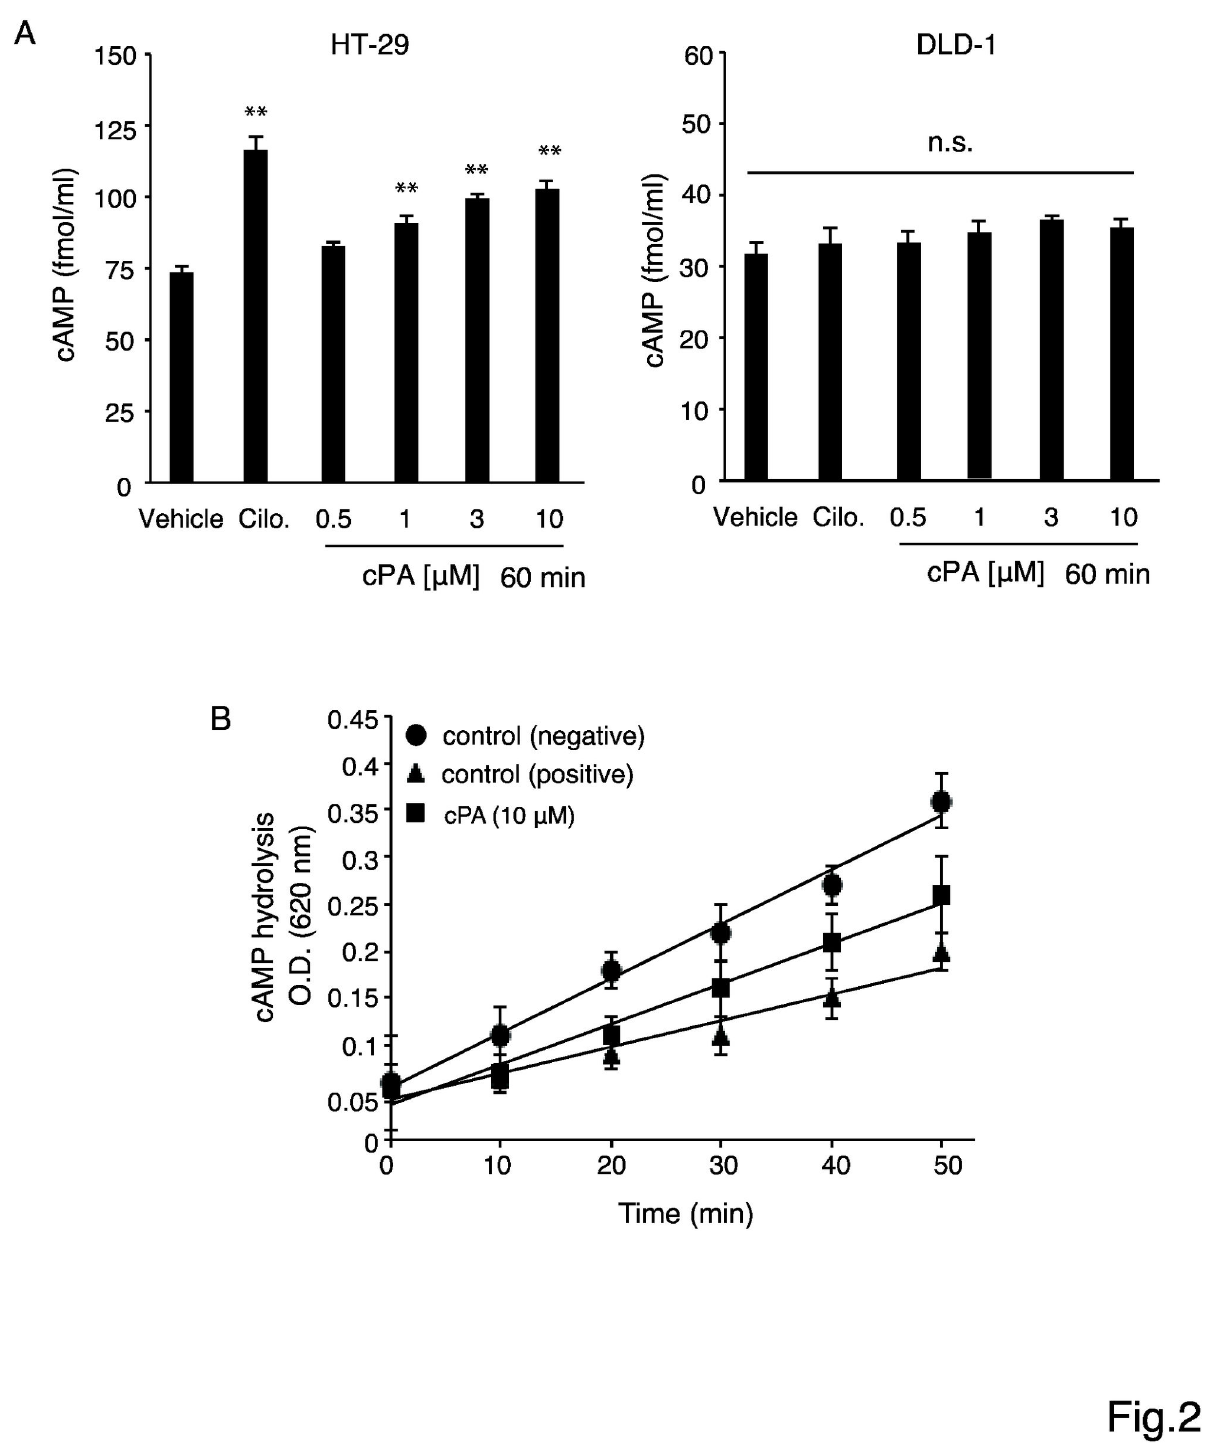
Figure 2. (A) Intracellular cAMP levels in HT-29 and DLD-1 cells treated with 0.5, 1, 3, or 10 μM cPA for 60 min. Intracellular cAMP levels in culture lysates were measured using the cAMP Biotrak Enzyme immunoassay system. Cilostazol (5 μM; Cilo) was used as a positive control. Data are expressed as means ± SEM (n = 4), **p < 0.01. (B) Time course of cPA-dependent inhibition of cAMP hydrolysis by PDE3B. PDE3B was incubated with cAMP and 5′-nucleotidase with or without the cPA (10 μM) for 10–50 min; the PDE inhibitor IBMX (50 μM) was used as a positive control. doi: 10.1371/journal.pone.0081139.g002 PLOS ONE |